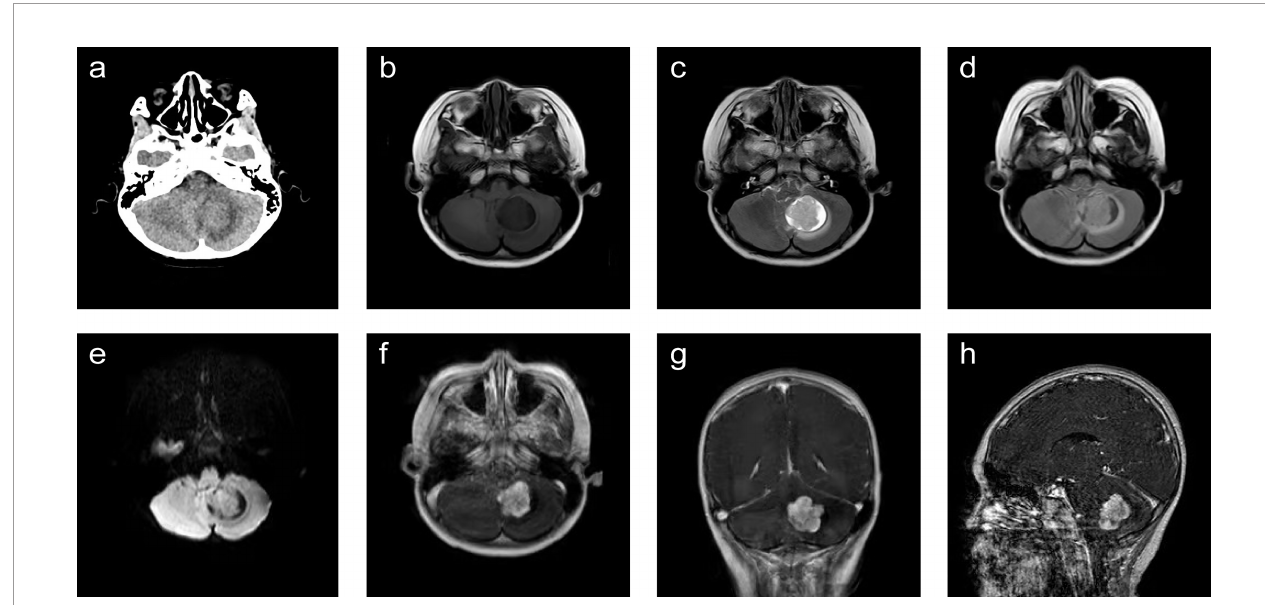
FIGURE 1 | Radiological evaluation of yolk sac tumor before operation. A noncontrast CT scan showed a slightly hyperdense mass located in the left cerebellar hemisphere (A) . The tumor was slightly hypointense on axial T1-WI (B) and slightly hyperintense on axial T2-WI, FLAIR and DWI (D, E) . Postcontrast (gadolinium- enhanced) axial, coronal and sagittal MRI showed prominent homogeneous enhancement (F ‒ H) . The fourth ventricle was compressed and narrowed. Mild edema was noted around the lesion. (B – H) . WI, weighted